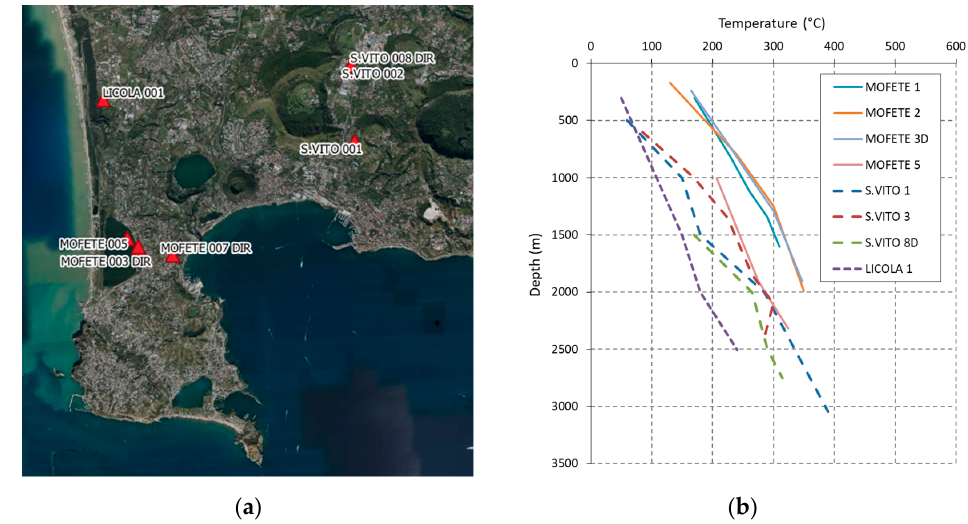
Figure 3. Campi Flegrei caldera: ( a ) Location of deep wells; ( b ) Temperature profiles (Modified after [21]).